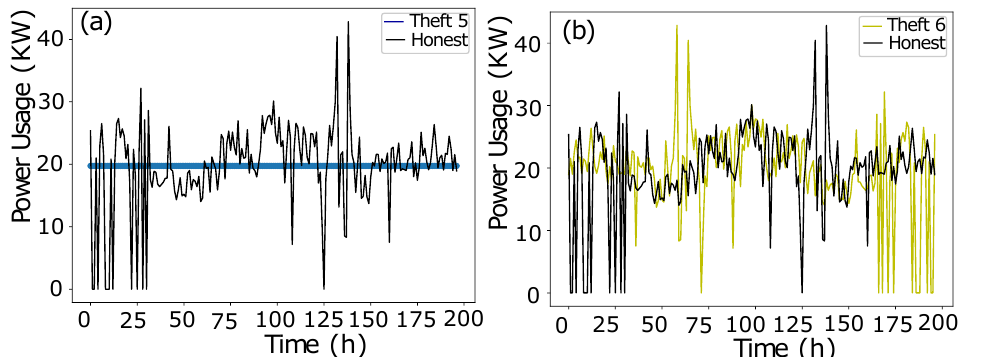
Figure 3. ( a ) Theft Case 3. ( b ) Theft Case 4.